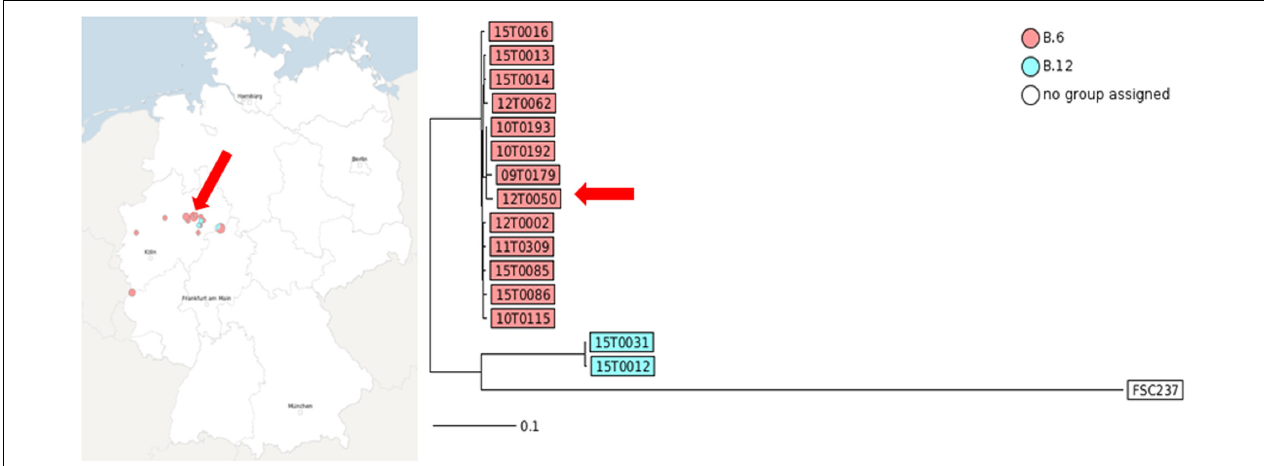
FIGURE 4 | MLST + of the strains showing the distance based on 1147 core genome MLST loci generated with SeqSphere. The graphic scale equals 0.1 difference of a MLST locus. Red colored isolate numbers indicate assignment to clade B.6, blue to clade B.12. The arrow marks the position of 12T0050.